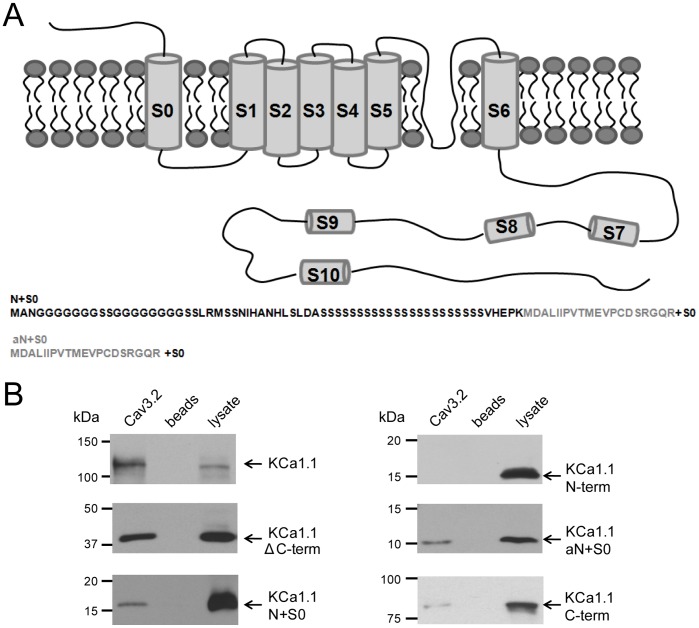
Cav3.2 channels interact with the N-terminal transmembrane region of KCa1.1 channels.
A, A schematic drawing of the α-subunit of KCa1.1 with the N-terminal segment. Two alternate N-terminal splice variant sequences are shown below the diagram (N+S0, aN+S0) with S0 designating the transmembrane component of the N-terminal region. Region of overlap between KCa1.1 N+S0 and aN+S0 are shown in grey shading. Constructs tested include full length KCa1.1, KCa1.1 N+S0, KCa1.1 aN+S0, KCa1.1 N-terminus, KCa1.1 without C-terminus (KCa1.1ΔC-term), and KCa1.1 C-terminus (n = 4). B, Left column, Western blots from lysates of tSA-201 cells indicating that Cav3.2 protein coimmunoprecipitates with full length KCa1.1, KCa1.1ΔC-term, or KCa1.1 N+S0. Right column, Cav3.2 channels coimmunoprecipitate with KCa1.1 aN+S0 but not with the KCa1.1 N-terminus. A weak binding was also observed with KCa1.1 C-terminus and Cav3.2. In both panels B and C the first lane corresponds to an immunoprecipitation conducted with a polyclonal Cav3.2 antibody. In the second lane, the precipitating antibody was omitted (i.e., bead only control), and the third lane corresponds to tsA-201 cell lysate. In each case, Western blots were probed with an anti-myc antibody to detect myc-tagged KCa1.1 channels or their fragments. Sample sizes are shown in brackets.